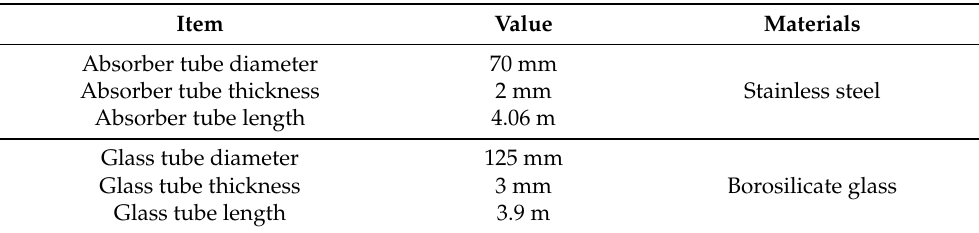
Table 1. Main parameters of each of the eight evacuated tubes in series (model HCEOI12, data Archimede Solar